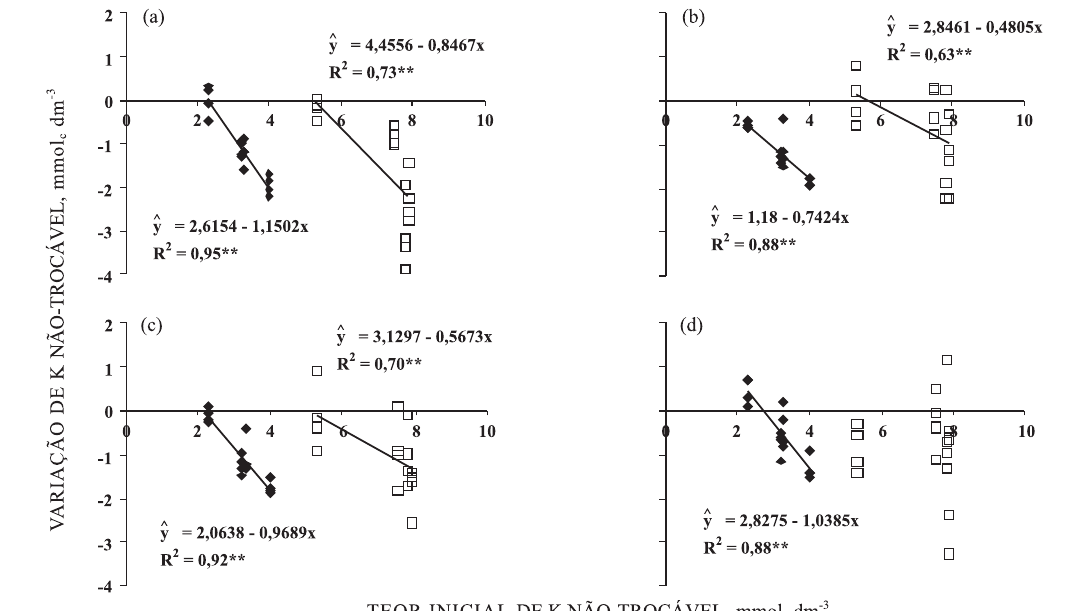
Figura 4. Correlação entre a variação do teor de potássio e o teor inicial de potássio não-trocável do solo proveniente da adubação residual e da complementar com 80 kg há -1 de K nas profundidades de 0–5, 5–10, 10–20 e 20–40 cm (a, b, c e d, respectivamente). ( ): Textura média (